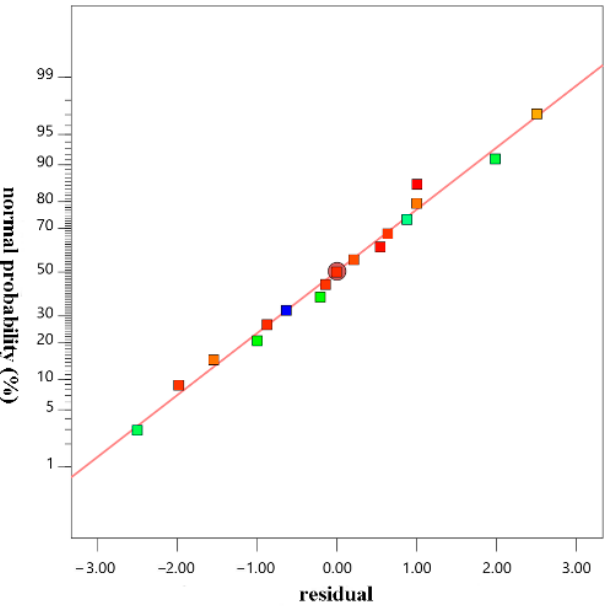
Figure 9. Normal Distribution Plot of Residuals.